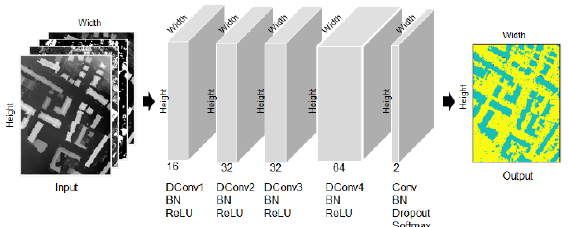
Figure 5. Proposed FCN architecture for ground